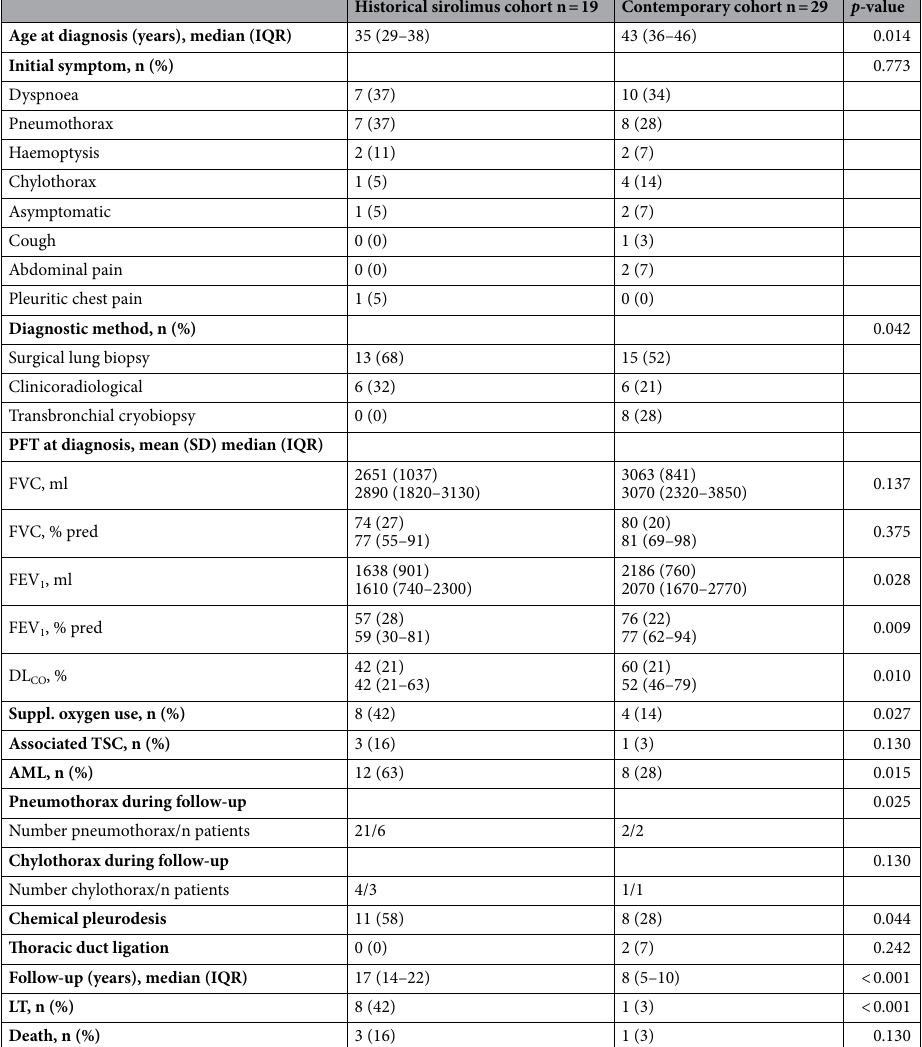
Table 1. Comparison between historical sirolimus cohort (sirolimus not available at diagnosis) and contemporary cohort. IQR interquartile range, SD standard deviation, PFT pulmonary function test, TSC tuberous sclerosis complex, AML angiomyolipoma, LT lung